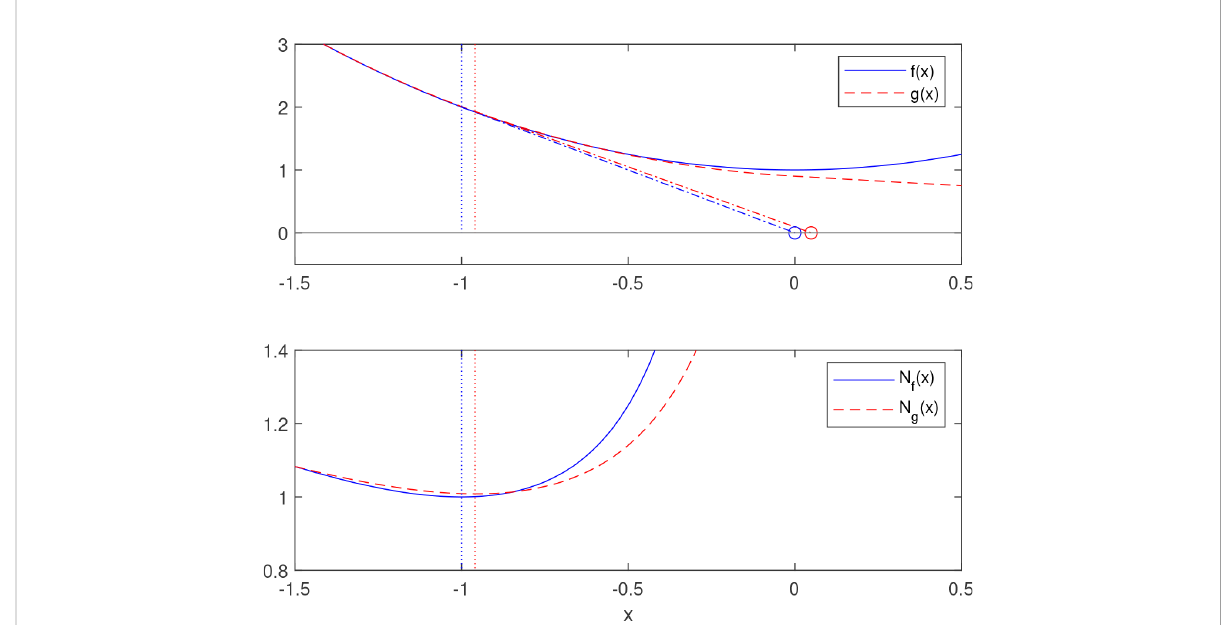
FIGURE 2 Minimization of a quadratic function according to Lemma 1. The function f ( x ) is quadratic and the corresponding N f ( x ) in the lower plot attains the minimal value 1 for x = − 1 (blue dotted line). In the upper plot, the intersection of the tangent of f ( − 1) and the X -axis corresponds to the minimizer X =0. The function g ( x ) is an approximation of f ( x ) . By minimizing N g ( x ) (red dotted line) and drawing the tangent in the same way, an approximation of the minimized of f ( x ) is